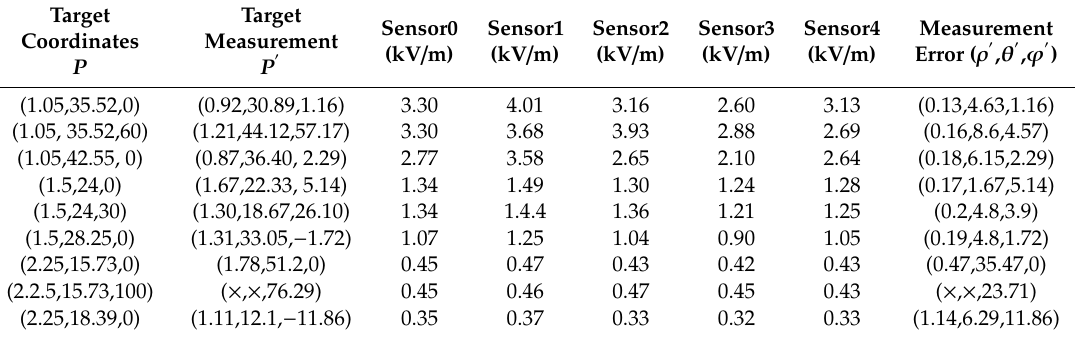
Table 5. Experimental